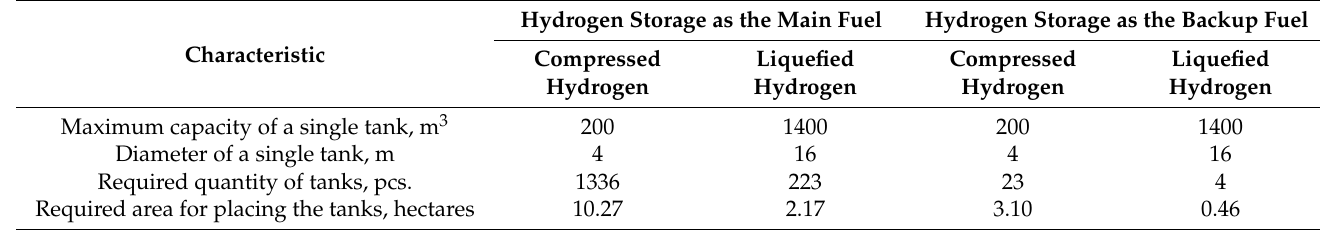
Table 8. The number of hydrogen storage tanks as the main and backup fuel, as well as the areas required to accommodate the hydrogen storage